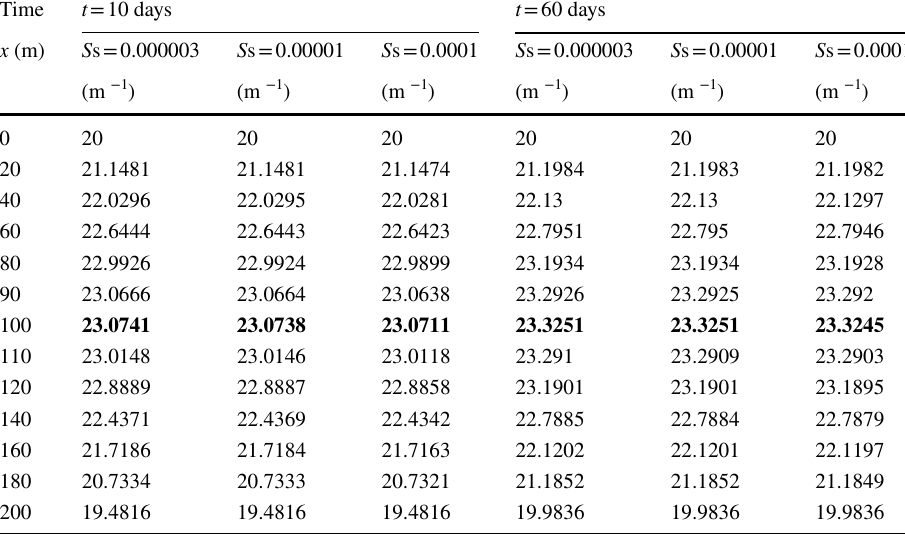
Table 2 The effect of variation in specific storage ( S s ) on the groundwater hydraulic head at t = 10 days and t = 60